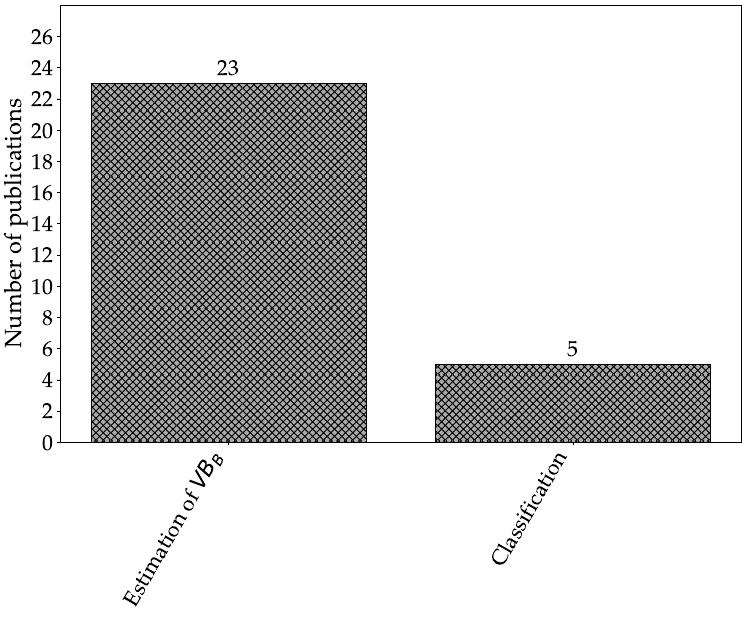
Figure 14. Repartition of outputs for fuzzy